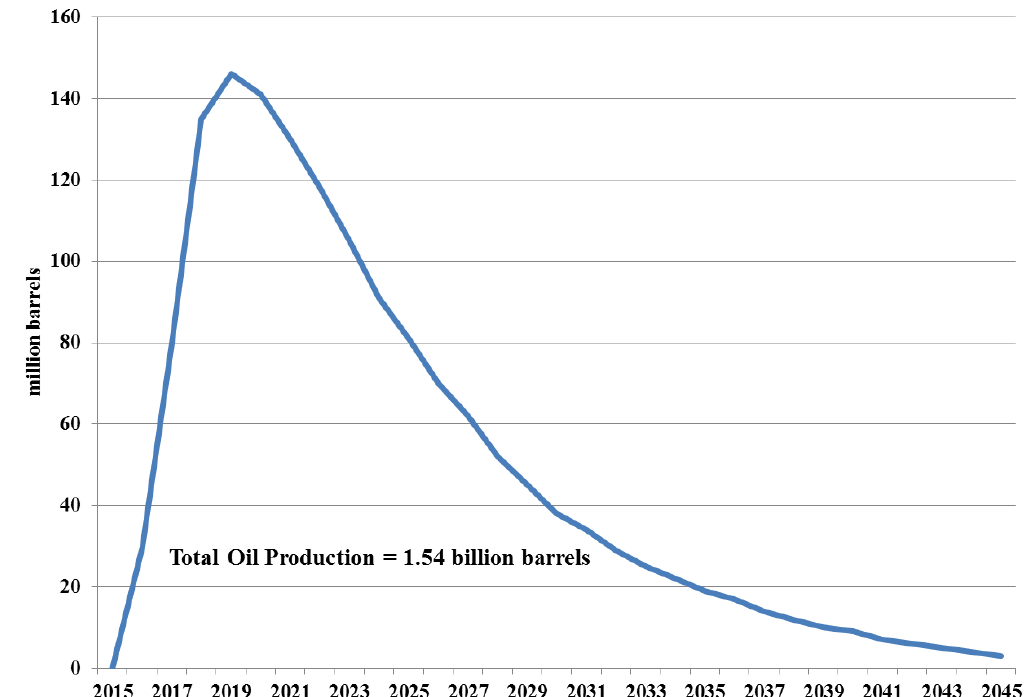
Figure 6. Possible new crude oil production from Santa Barbara